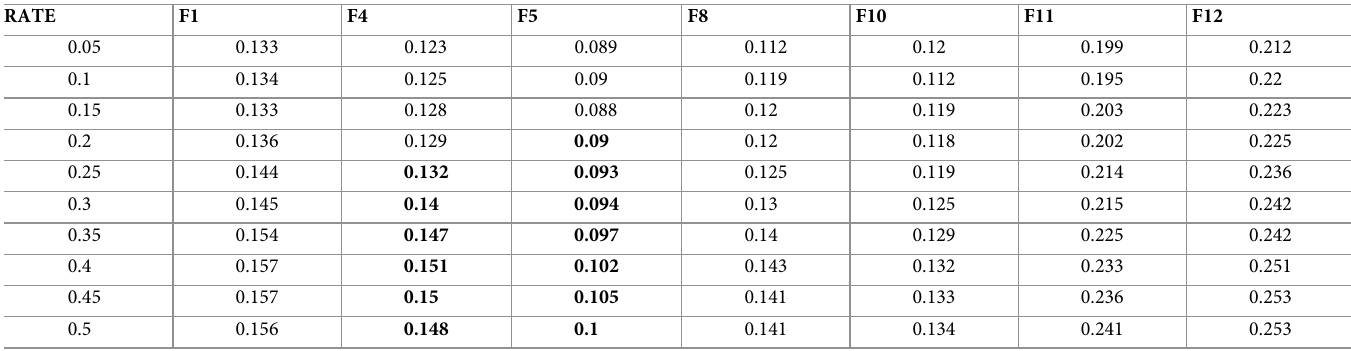
Table 15. MAE of MICE by